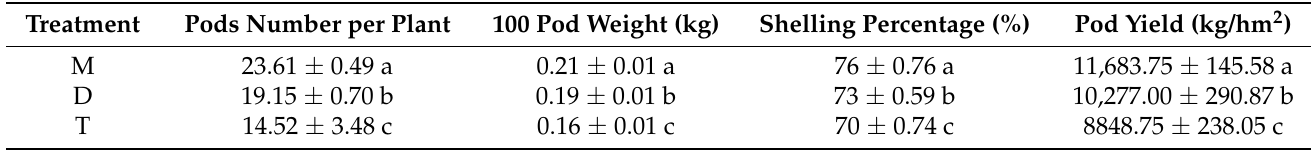
Table 9. Effect of seeding pattern on yield and yield component of